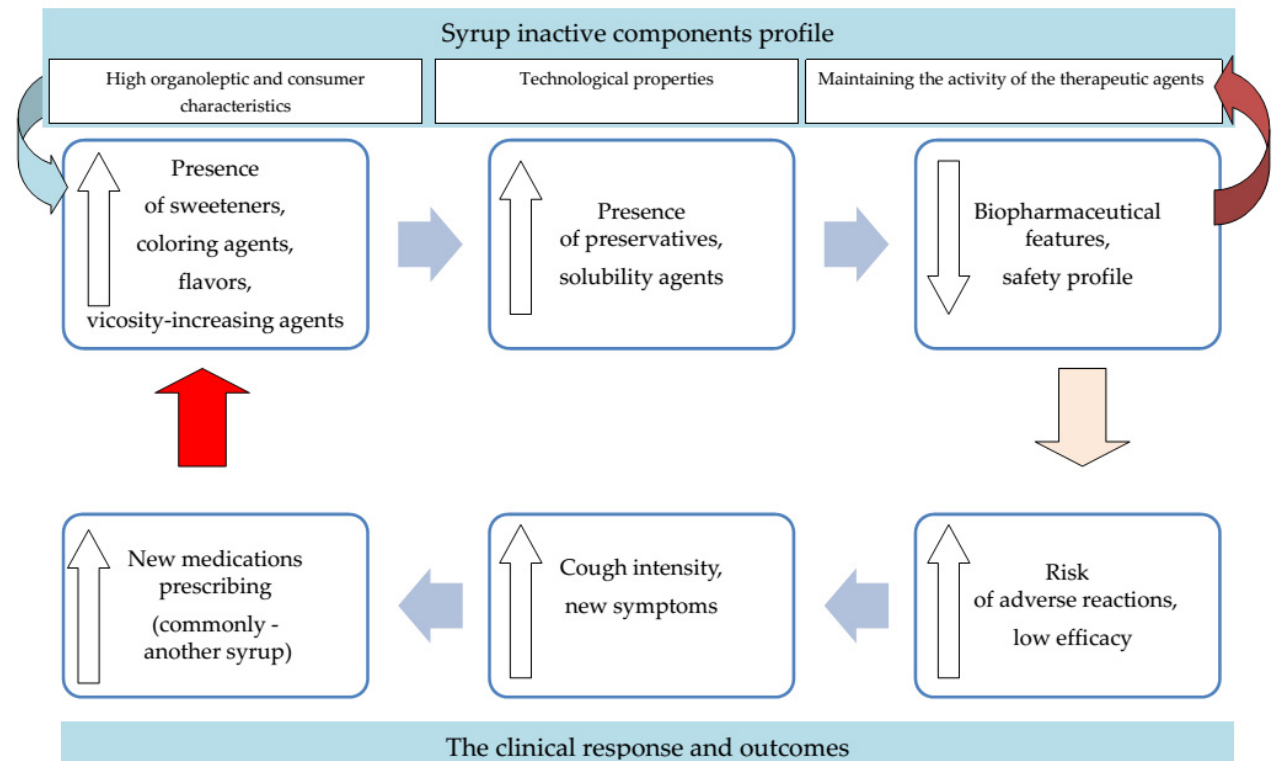
Figure 3. The mechanism of the “vicious circle” initiated by inadequate excipients composition of phytomucolytic syrup.